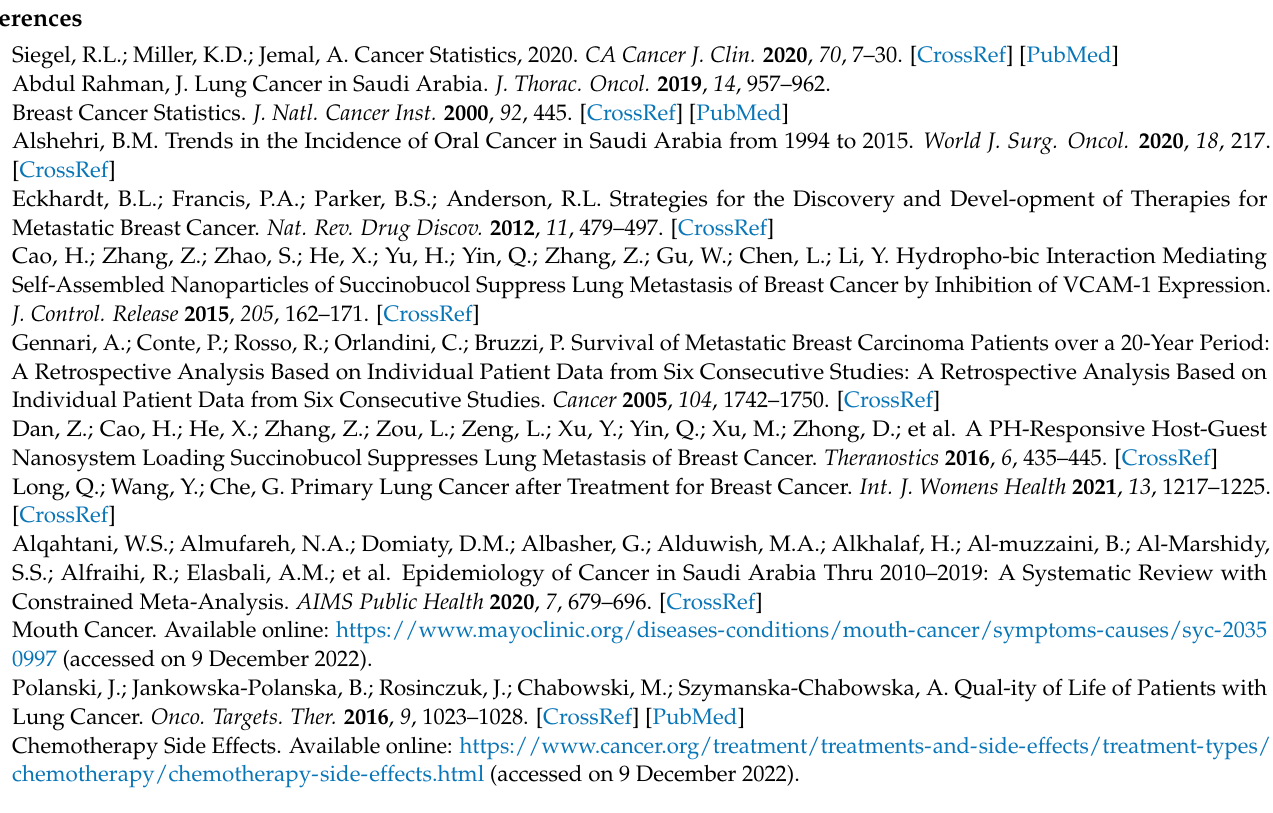
against noncancerous L929 cell line. Cisplatin was used as a standard drug; Figure S2: Cytotoxic activity of F. arabica against Lung cancer A549 cell line. Cisplatin was used as a standard drug; Figure S3: Cytotoxic activity of F. arabica against Breast cancer MCF-7 cell line. Cisplatin was used as a standard drug. Figure S4: Cytotoxic activity of F. arabica against Breast cancer MCF-7 cell line. Cisplatin was used as a standard drug; Figure S5: GC chromatogram and mass spectra of methanol extract of F. arabica ; Figure S6: LCMS chromatogram and mass spectra of methanol extract of F. arabica